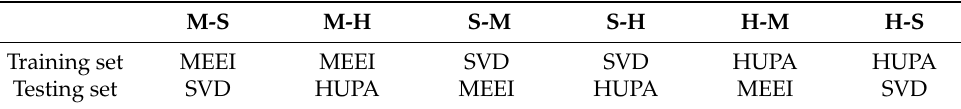
Table 3. Cross-database experiment